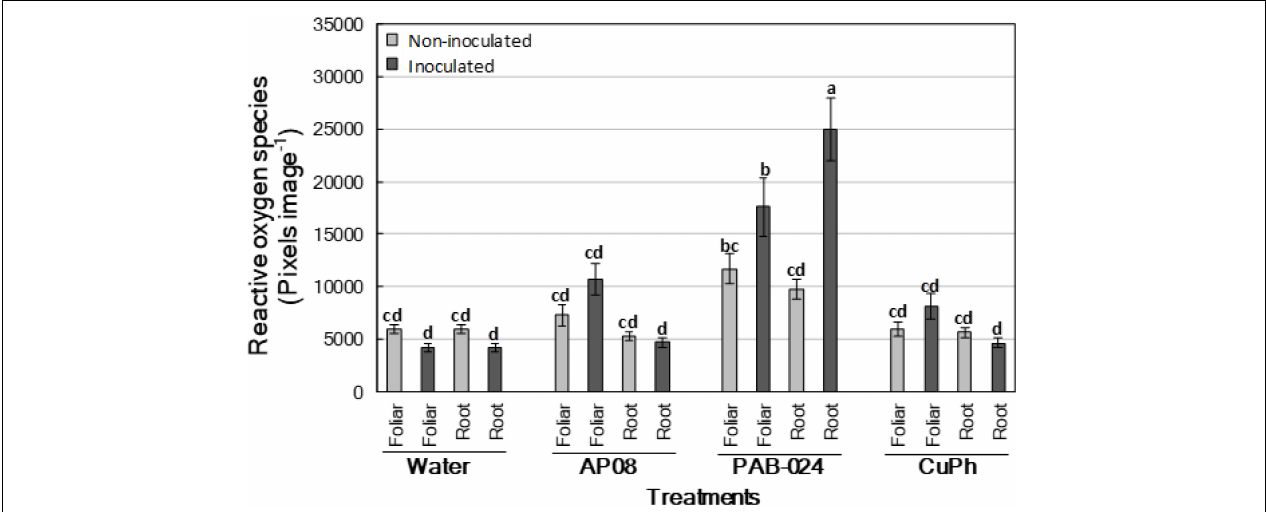
FIGURE 2 | Hydrogen peroxide (H 2 O 2 ) staining [reactive oxygen species (ROS); pixels image – 1 ] estimated by using DAB staining in the leaves of olive plants of cv. Picual, which were noninoculated (light gray columns) or inoculated (dark gray columns) with Verticillium dahliae , 3 months after treatment by spray (foliar application) or irrigation (root application) with the following products: water (Control), Aureobasidium pullulans (AP08), Bacillus amyloliquefaciens (PAB-024) and Copper Phosphite (CuPh). Columns represent the mean of 30 plants (two experiments with three replicated blocks and five plants per block each). Columns with common letters do not differ significantly according to Tukey’s HSD test at P = 0.05. Vertical bars are the standard error of the